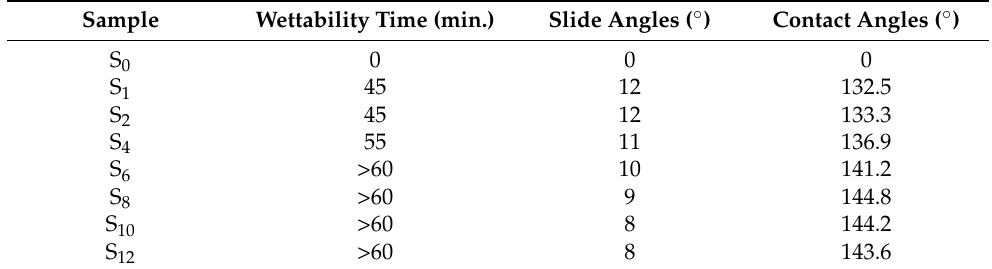
Table 2. Wettability time, and slide and static contact angles of pristine and treated cellulosic fabrics. Sample